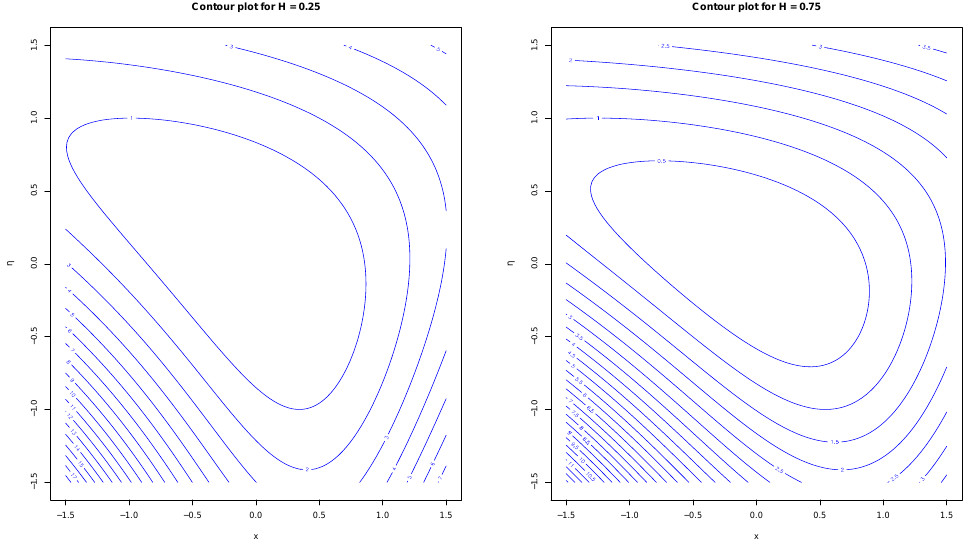
Figure 1. The contour plots. Parameters ρ = − 0.7, ν = 1, y 0 = 1, t = 0.5. H = 0.75 on the right ; H = 0.25, on the left